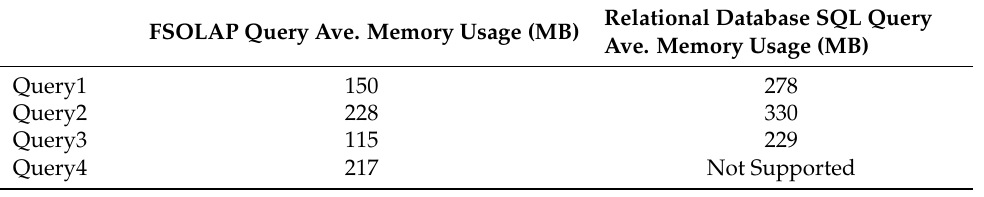
Table 6. Comparision of average memory usages between FSOLAP and relational database SQL queries.